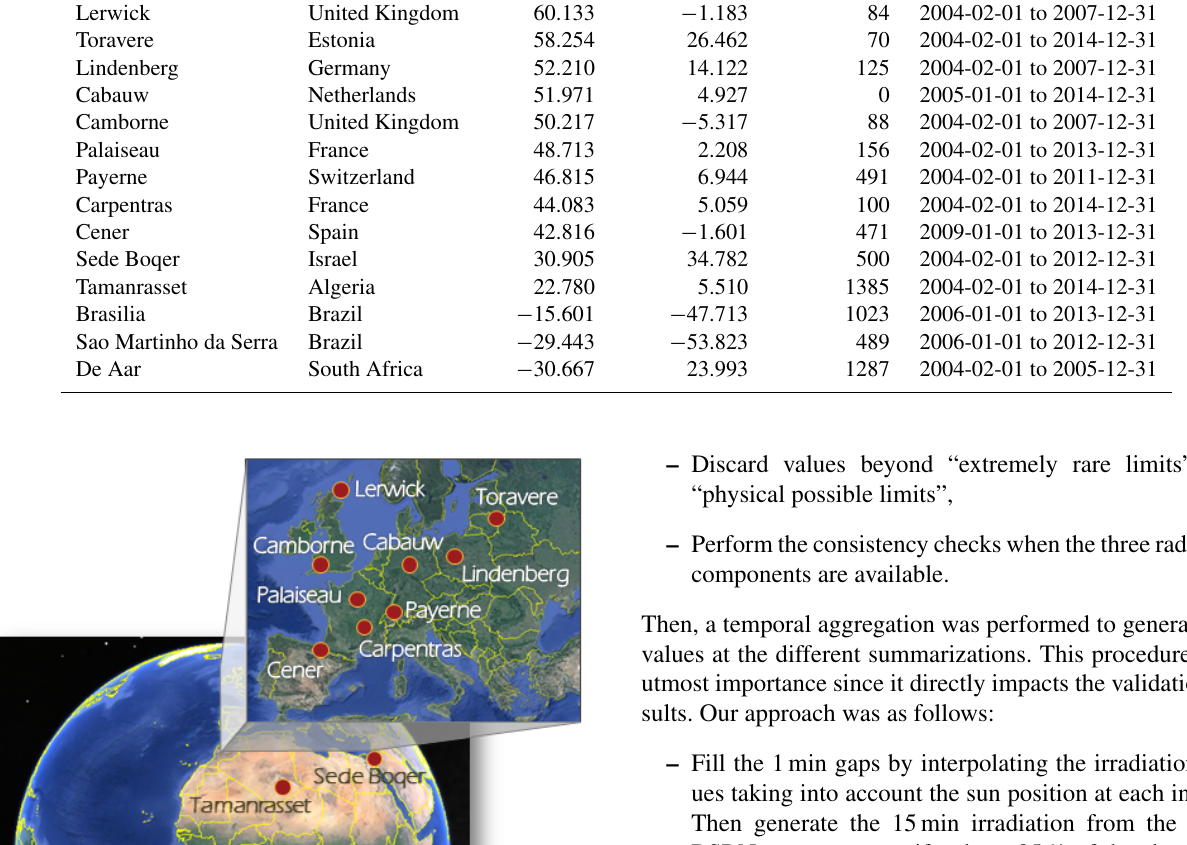
Table 1. List and main characteristics of the BSRN stations used for the quality assessment. Station